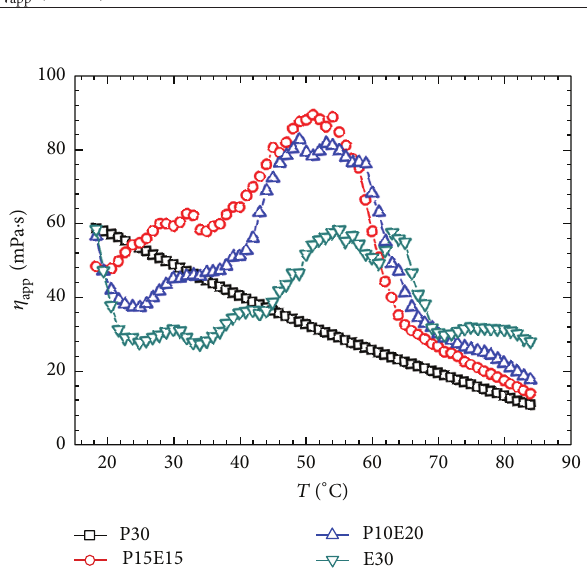
Figure 1: Effect of temperature on apparent viscosity of the samples (TDS = 32,868 mg/L, [Ca 2+ ] + [Mg 2+ ] = 873 mg/L, ̇𝛾 = 7.34s −1 , heating rate: 2 ∘ C/min). Figure 2: Storage modulus (